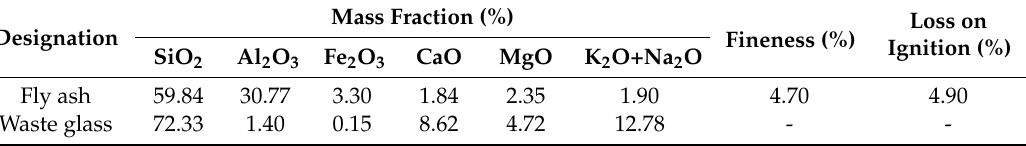
Table 1. The chemical composition and physical indicators of the fly ash and glass